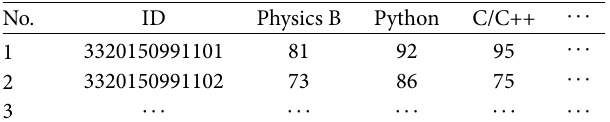
Table 1: Graduate transcript.